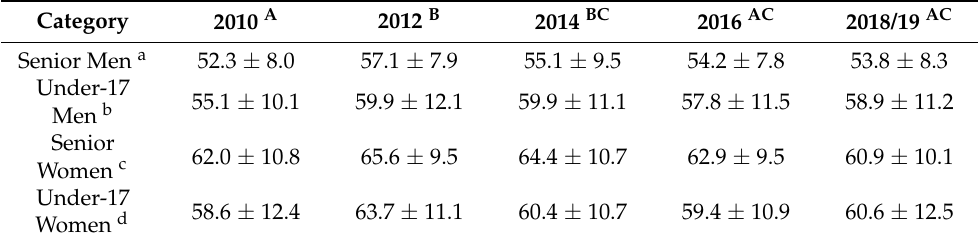
Table 2. Means and SDs of two-point shot attempts per 100 possessions.